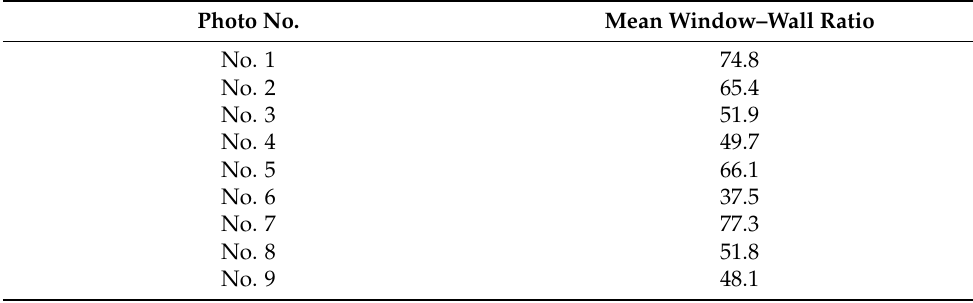
Table 3. The statistics of the window–wall ratio of the Chinese courthouse buildings.